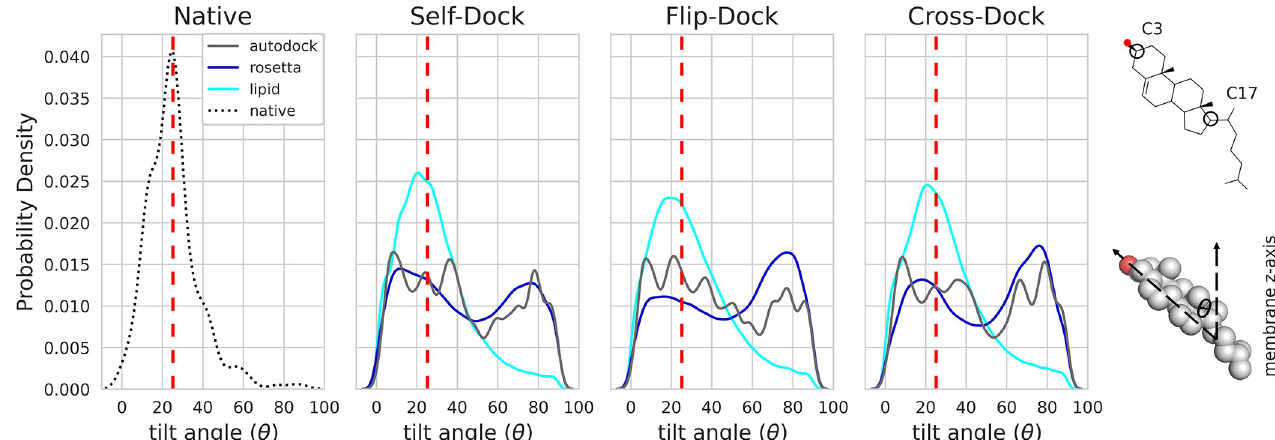
Fig 3. Cholesterol tilt angle in the self-dock, flip-dock, and cross-dock benchmarks. The tilt angle θ is defined as the angle between the sterol plane (C3 and C17 atoms) and the membrane normal (z axis). A probability density quantifies the tilt angle distribution. AutoDock is shown in gray, RosettaLigand in blue, and RC (lipid) in cyan. The tilt angle distribution found for cholesterol in experimental X-ray and cryo-EM structures is shown as a black dotted line. The red dotted line marks the average tilt angle of the native structure (25